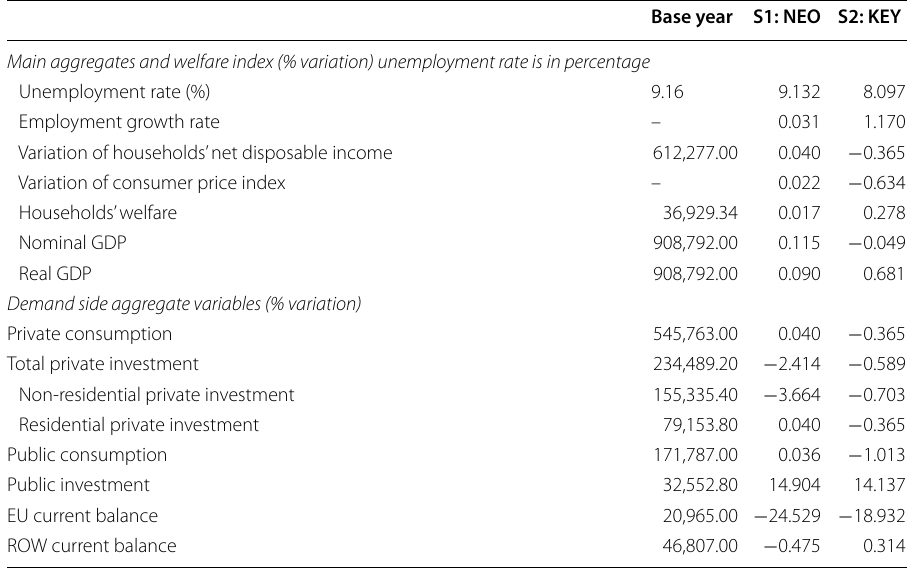
Base year S1: NEO S2: KEY